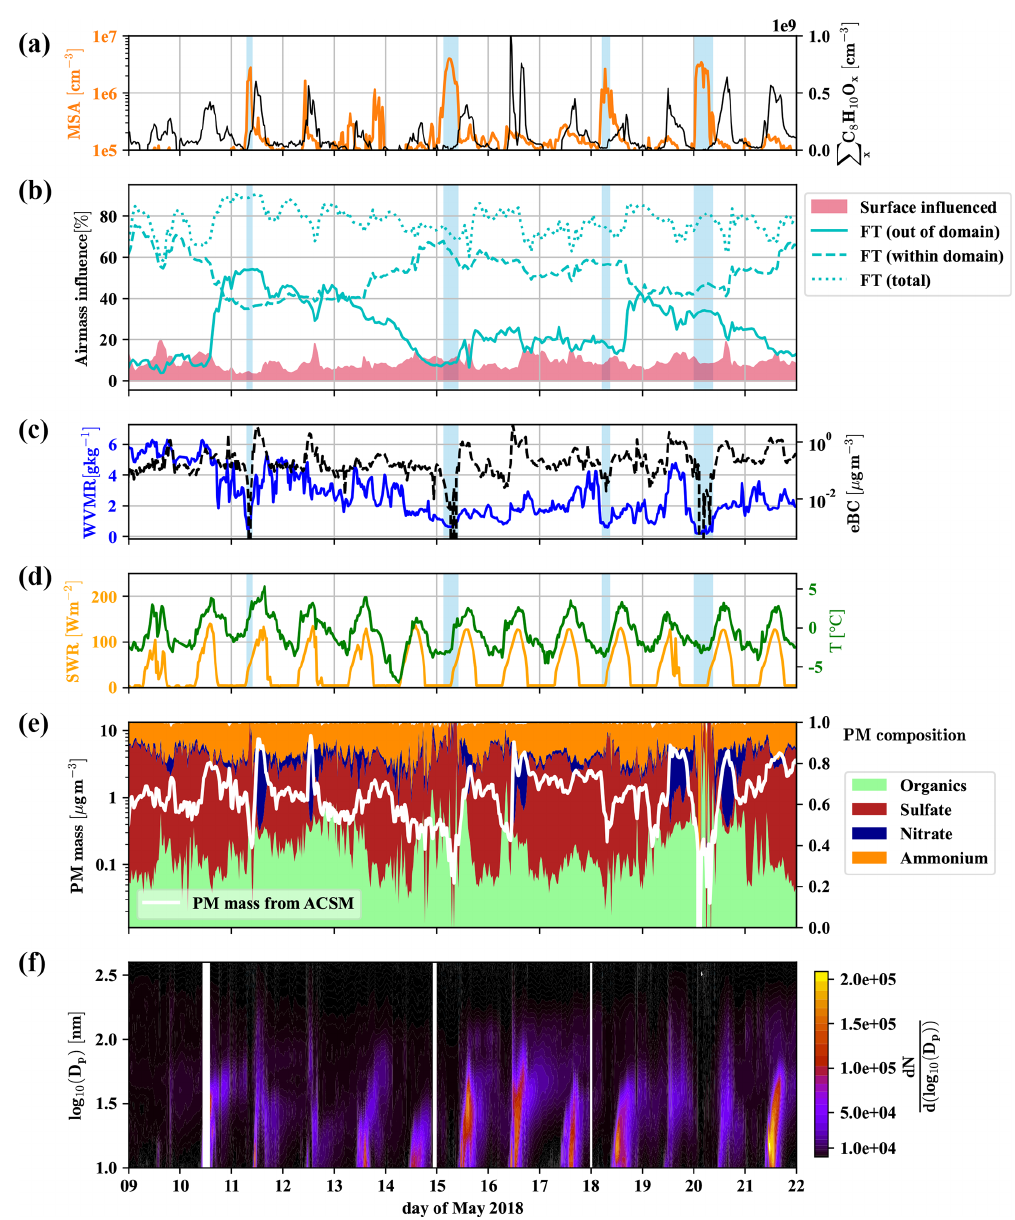
Figure 3. Overview of 2 weeks of data for the identification of free tropospheric periods. Methanesulfonic acid (MSA) and summed C 8 H 10 O x (a) , the influence of surface ( < 500ma.g.l.) and free tropospheric air masses ( > 1500ma.g.l.) according to FLEXPART, with free tropospheric (FT (total)) air masses shown additionally divided into the air from within and without the FLEXPART domain (b) , water vapor mixing ratio (WVMR, solid) and equivalent black carbon mass (eBC, dashed) (c) , shortwave radiation (SWR) and temperature ( T ) (d) , particle matter (PM) mass and composition from the Q-ACSM (e) , and particle number distribution ( d N blue shaded areas mark times that we consider dominated by free tropospheric air masses due to the low particle load and water vapor mixing